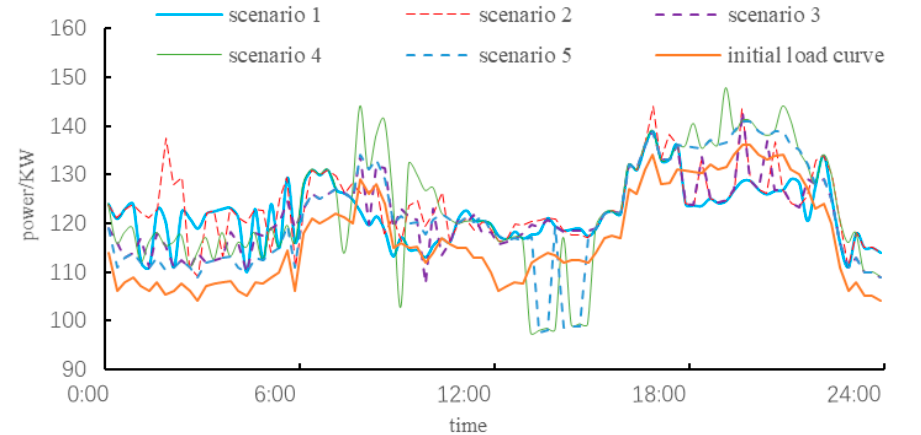
Figure 4. Daily load curve in different scenarios. Table 3. Variance of the microgrid load curve in different scenarios.